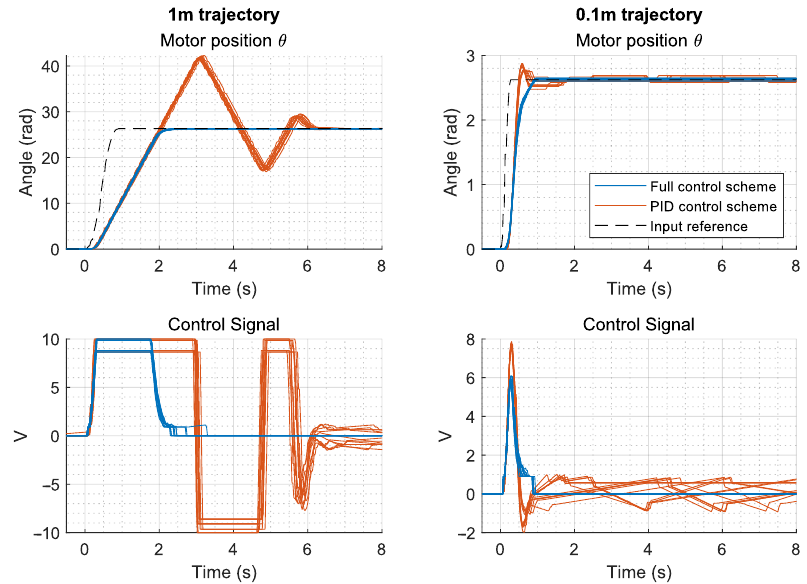
Figure 21. Motor results during robot trajectory tracking.